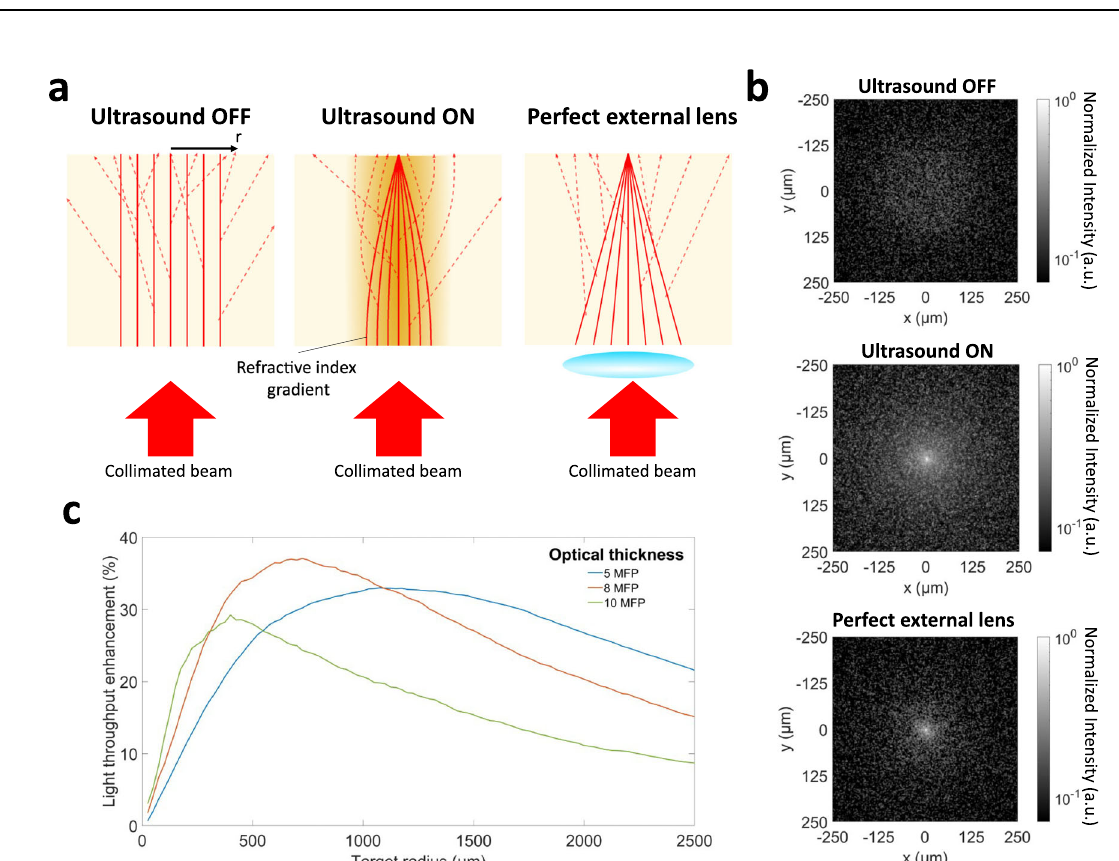
Fig. 2 Comparison of the spatial distribution of guided photons between a virtual GRIN waveguide and a perfect lens. a Schematic illustration of a collimated beam of light (ultrasound OFF) through a scattering medium, a virtual GRIN waveguide (Ultrasound ON), and an external lens con fi ning light through the medium. The target radius is shown as r on the schematic. b Images of scattered photons at the optical depth of 6 MFP for three cases of Ultrasound OFF, virtual waveguide (Ultrasound ON), and the external lens. c Light throughput enhancement for the virtual waveguide (Ultrasound ON) relative to a perfect external lens with matching focal spot size.